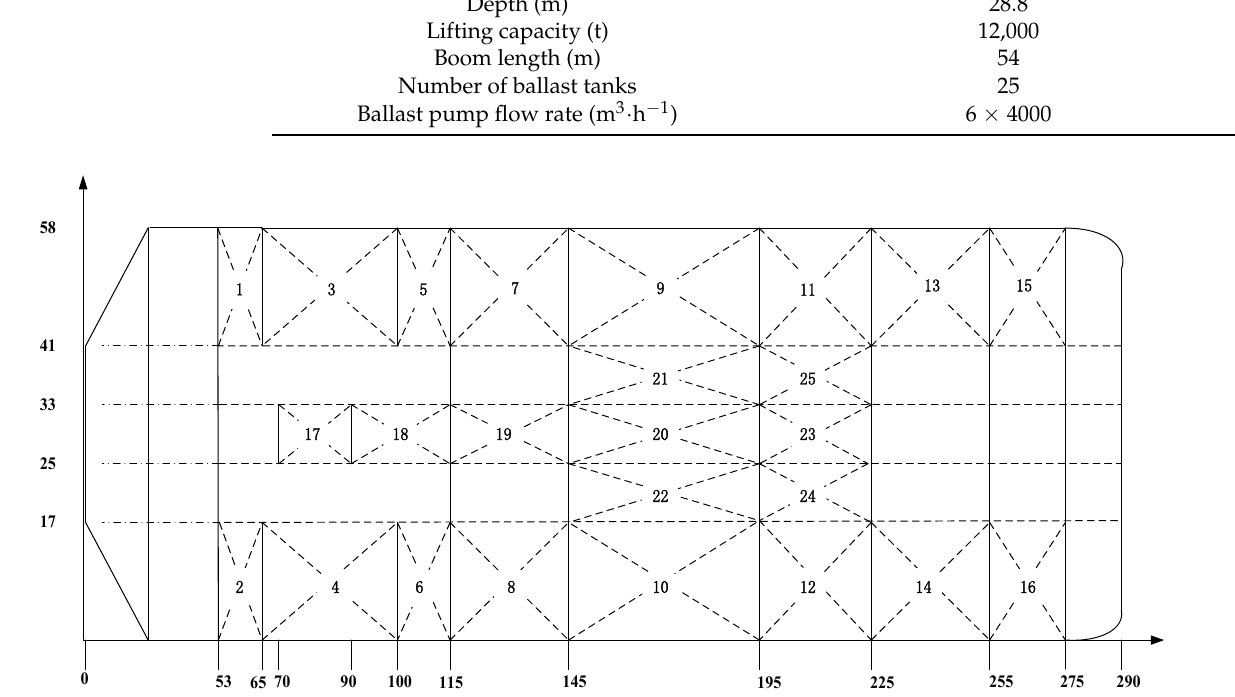
Figure 21. Top view of ballast tank layout of the RFC with 25 ballast tanks.